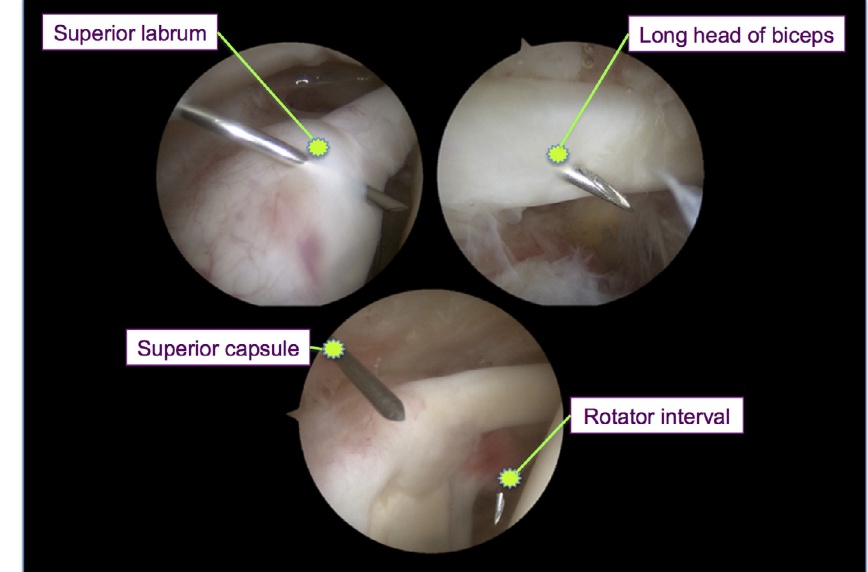
Figure 4. Determination of needle location from arthroscopic